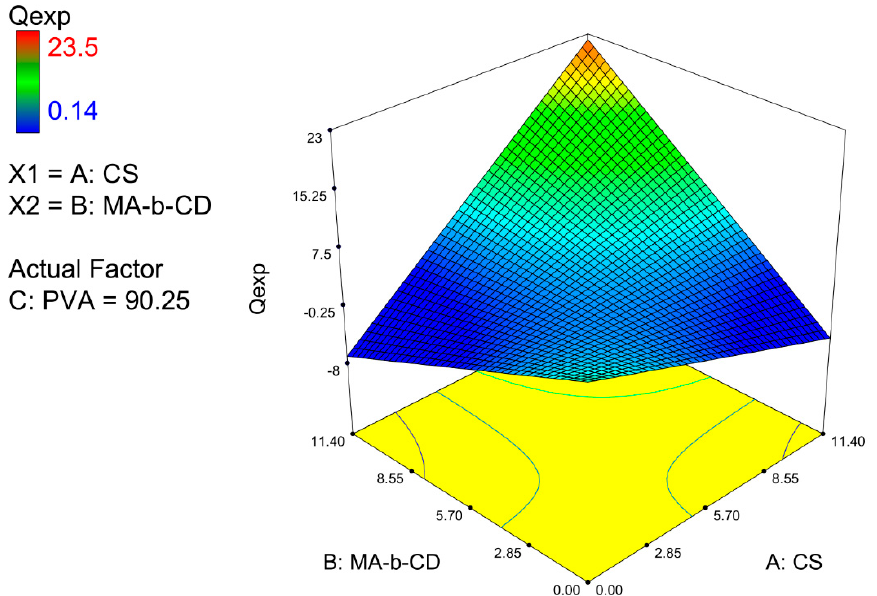
Figure 2. Three-dimensional response surface for the swelling ratio at equilibrium versus concentration of CS and MA- β -CD.